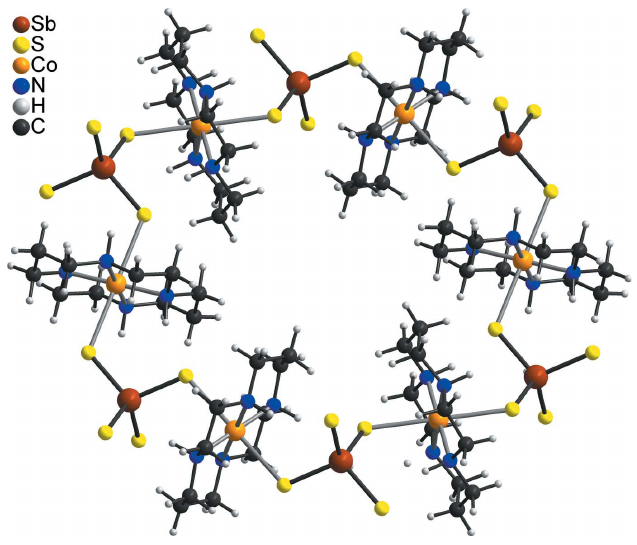
Figure 3 Crystal structure of the title compound with a view of an 24-membered ring composed of six Co cations and six [SbS 4 ] 3 (cid:3) anions.